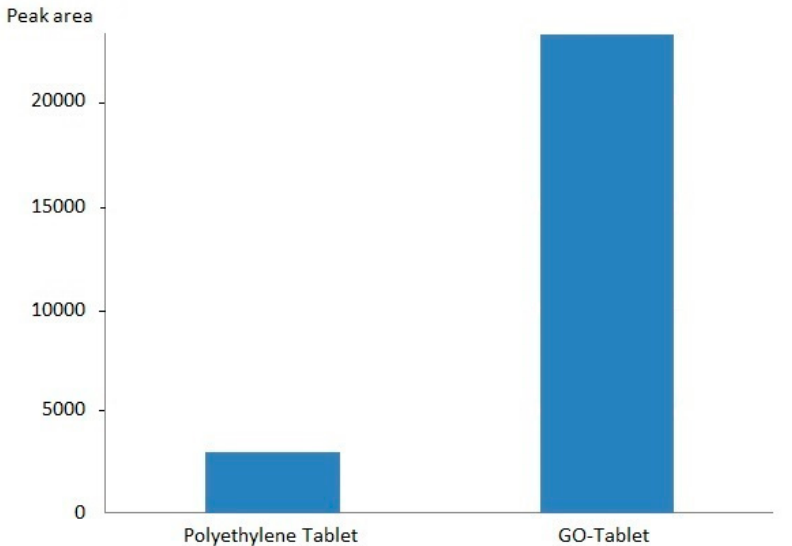
Figure 5. Efficiency of GO-Tabs and polyethylene blank tablet (saliva sample, 2000 nmol L − 1 ).